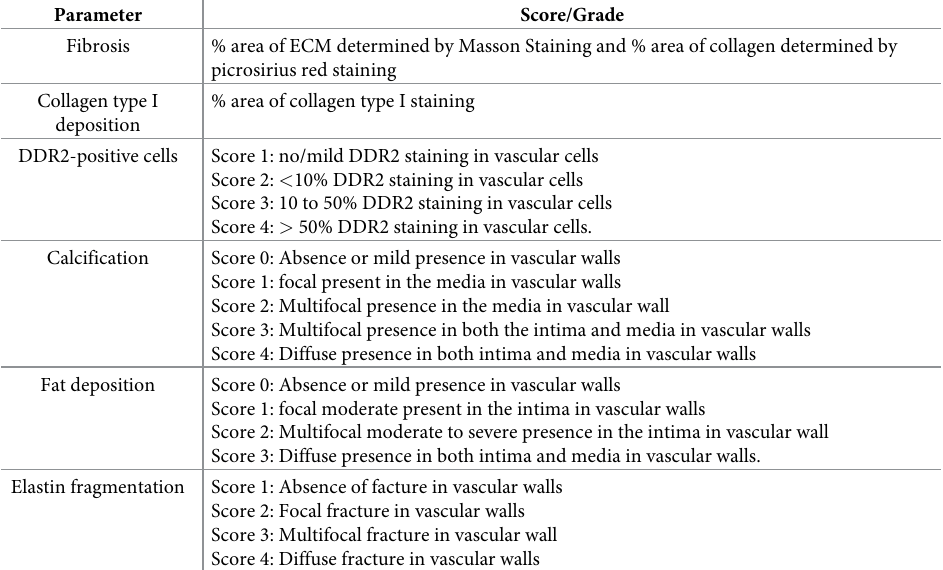
Table 1. Semi-quantification and quantification criteria for immunohistochemistry (Figs 7 and 8).